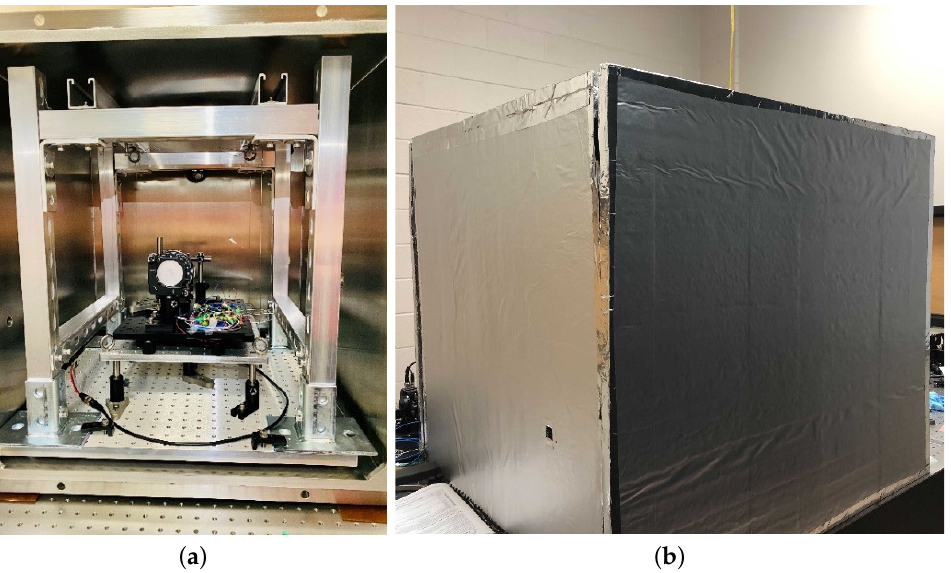
Figure 3. Operation environments. ( a ) Pendulum platform inside the chamber; ( b ) styrofoam thermal insulator outside the chamber. The compact interferometer is placed on a pendulum stage consisting of a breadboard and four steel wires. Viton strips are applied between the pendulum frame and the vacuum chamber to reduce ambient thermal coupling. The entire pendulum structure is fixed inside the vacuum